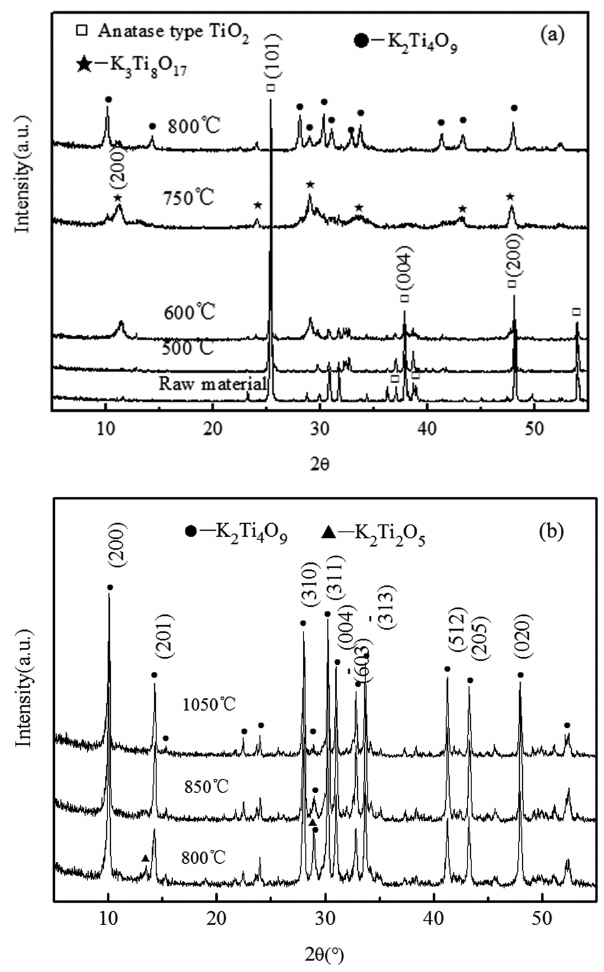
Figure 4: (a) XRD patterns of samples with T/K = 3 at a low tem- perature. (b) XRD patterns of samples with T/K = 3 at a high